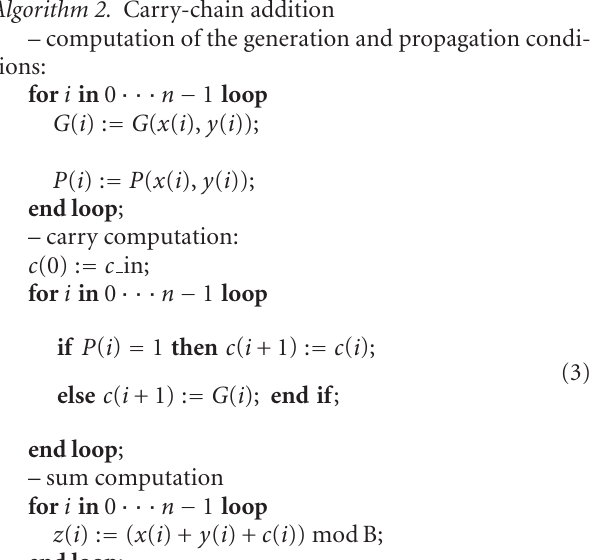
Algorithm 1 (pencil and paper) computes the ( n +1)-digit representation of the sum z = x + y + c in where c in is an initial carry equal to 0 or 1. Algorithm 1. Classic addition (ripple